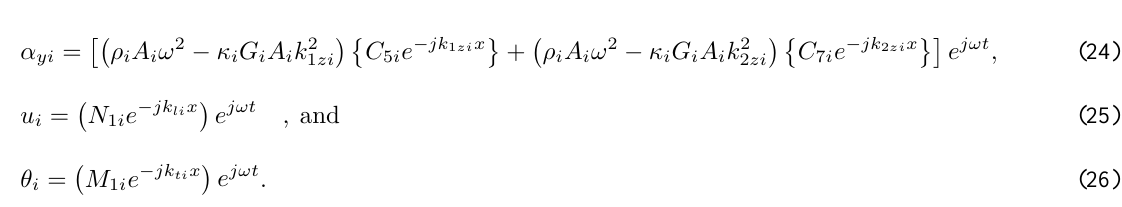
Fig. 4, continued. The power transmission and reflection coefficients of two semi-infinite Timoshenko beams with the same material and geometrical properties joined at 45 ◦ : (a) Case of the incident BDFW with wavenumber k 1 , (b) Case of the incident SDFW with wavenumber k 2 , (c) Case of the incident longitudinal